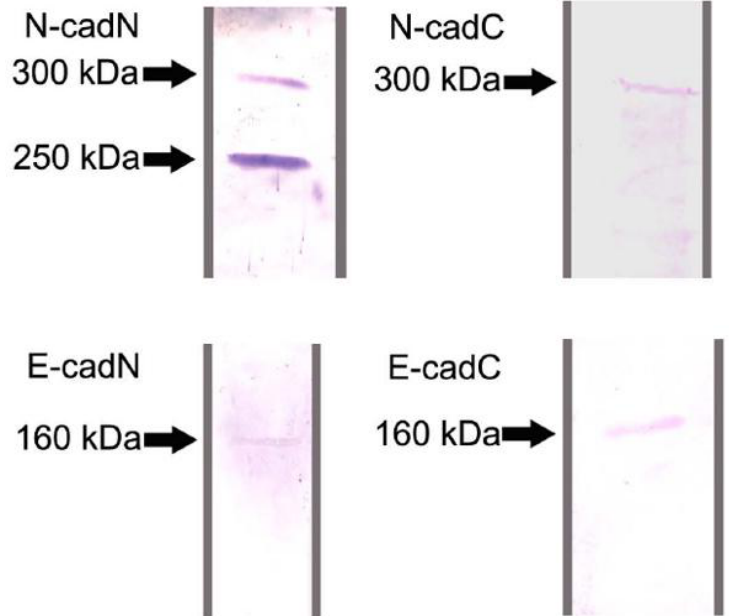
Figure 1. Western blot analyses with antibodies directed against the N- and C-terminal domains of Apis mellifera E- and N-cadherin, done on protein extracts of Apis mellifera larval testes. A 160 kDa protein was detected by the antibodies raised against the two E-cadherin domains (E-cadN and E-cadC). The antibody raised against C-terminal N-cadherin (N-cadC) detected a protein of approximately 300 kDa, which was also recognized by the antibody against the N-terminal domain (N-cadN), the latter additionally reacting with a protein of approximately 250